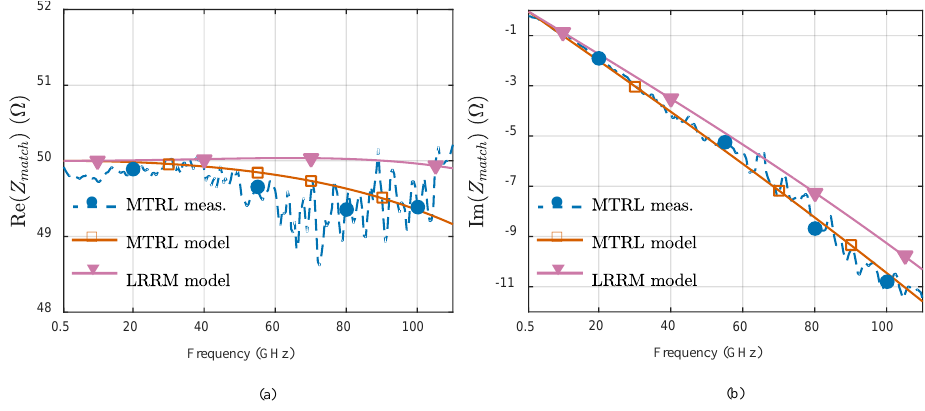
Figure 4. Real ( a ) and imaginary ( b ) part of the 50 Ω match impedance. “MTRL meas.” denotes the impedance measured with multiline thru-reflect-line (MTRL) calibration, “MTRL model” denotes the impedance fitted from “MTRL-meas.”, and “LRRM model” denotes the load impedance determined by LRRM calibration.